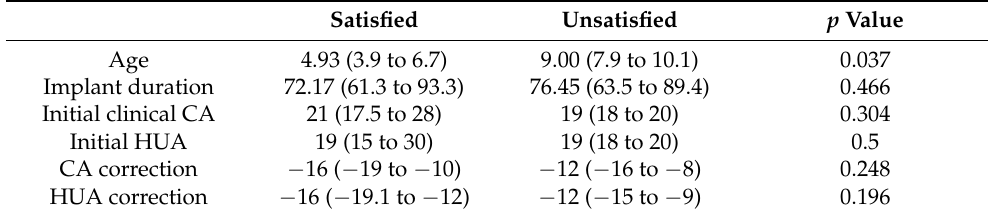
Table 2. Comparison results between satisfied and unsatisfied patients for different variables.